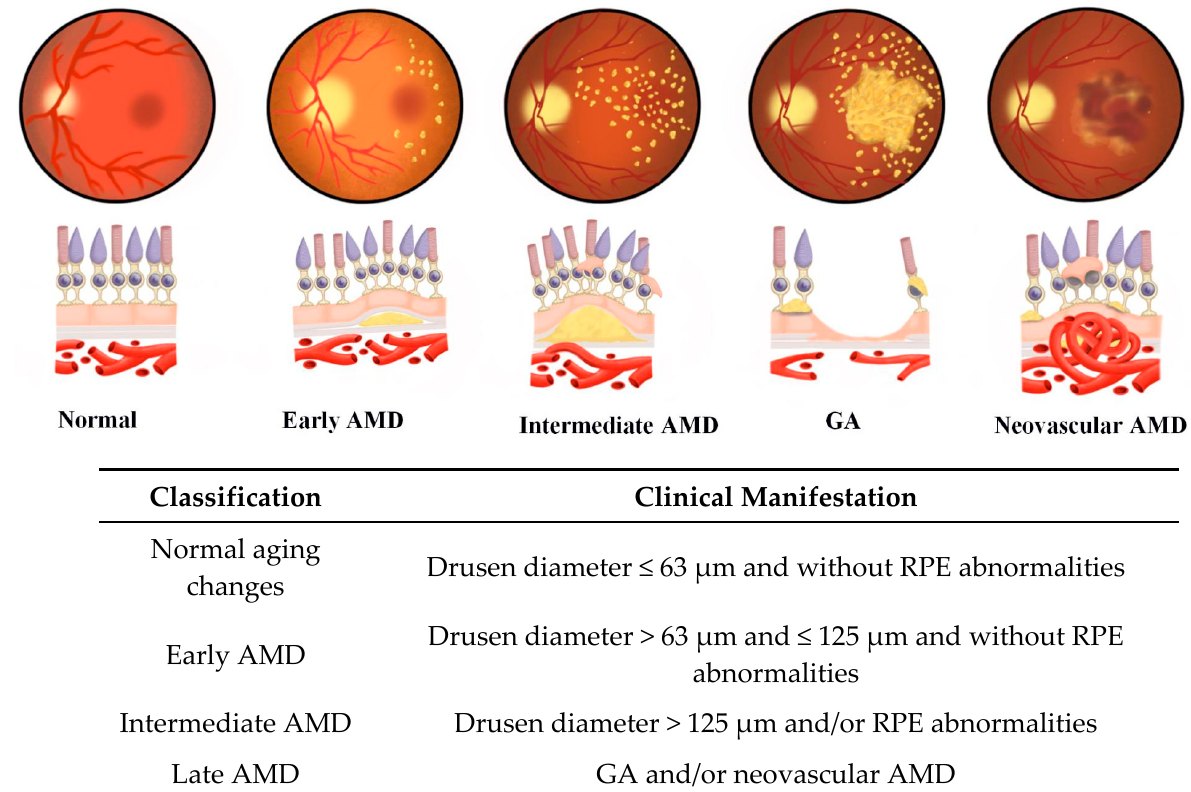
Figure 1. The Beckman clinical classification of age-related macular degeneration (AMD) [4].